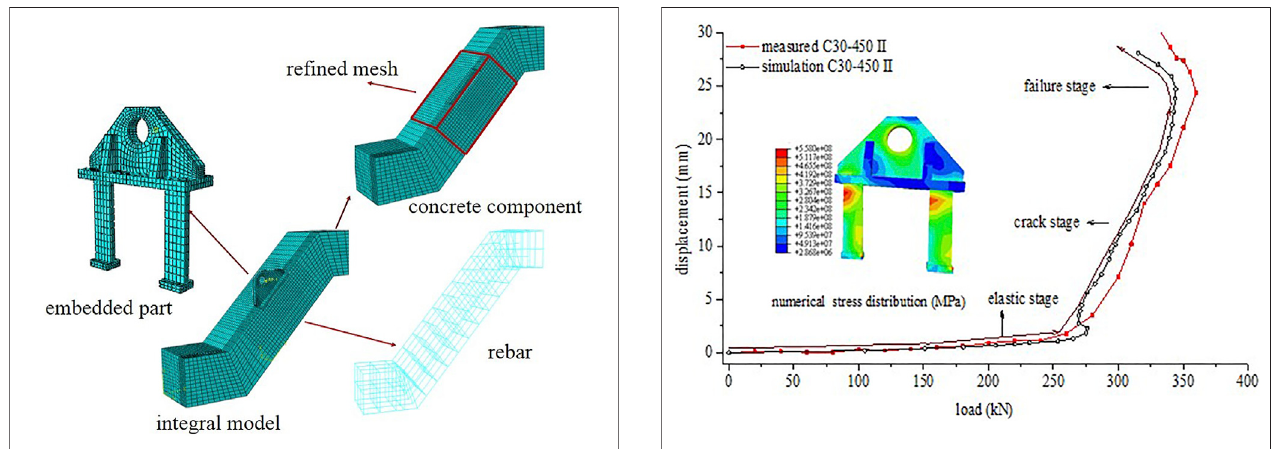
FIGURE 12 | Load-displacement comparison in experiment and